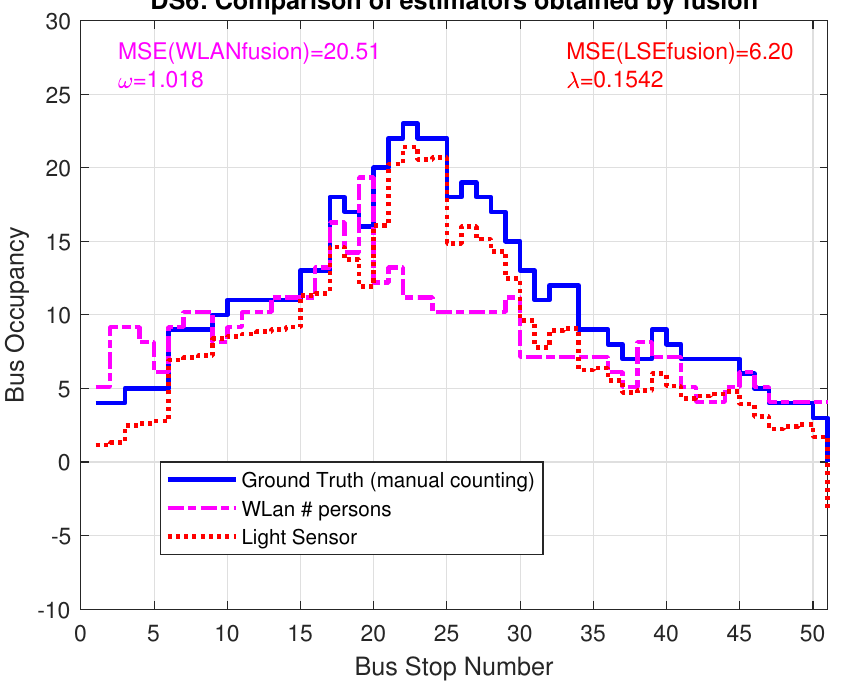
Figure 13. Bus occupancy (LSE) and number of detected devices (WLAN) for trace DS6 WITHOUT inclusion of λ and ω from the fusion approach. DS6: Comparison of estimators obtained by fusion